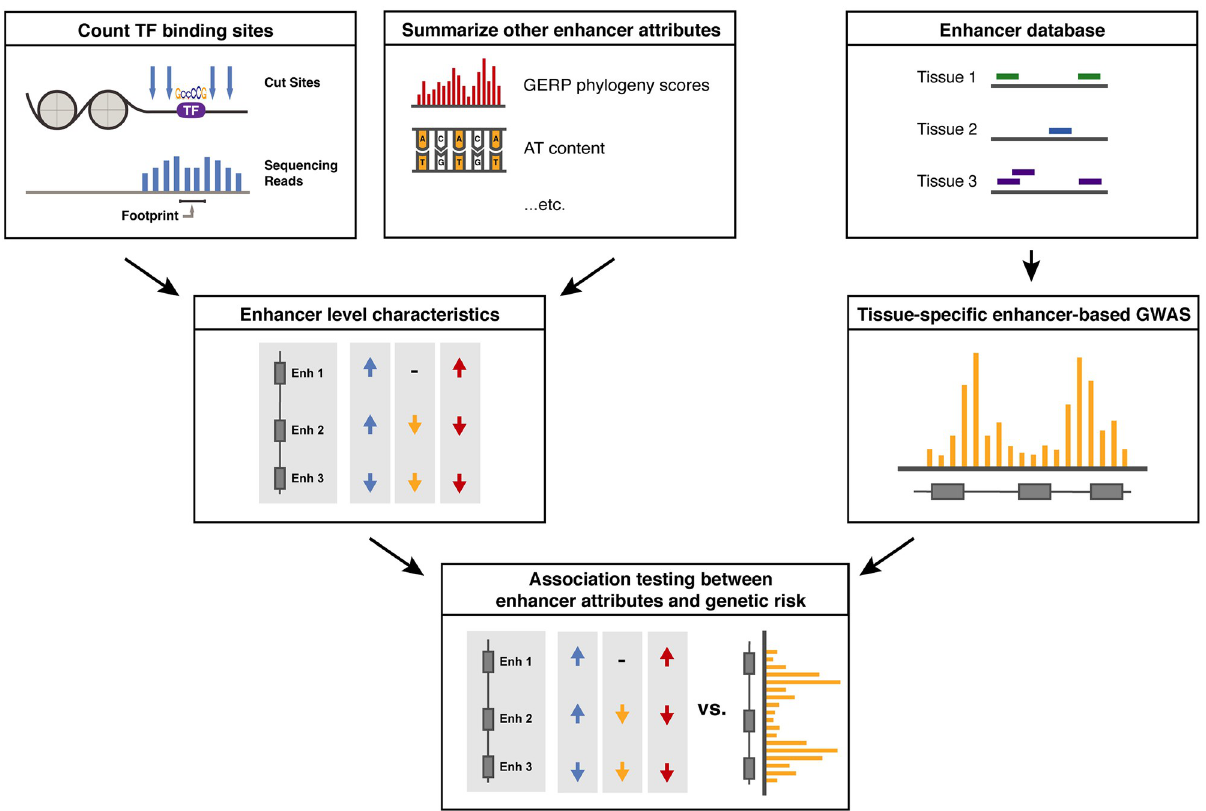
Fig 1. RWAS workflow overview. In brief, the RWAS workflow involves annotating SNPs to enhancers and other regulatory regions (rather than genes). Enhancer-level summary statistics are computed for input into association testing. Then, we use the MAGMA linear modeling framework to compute genetic associations between supplied enhancer-level covariates and these enhancer-based GWAS summary statistics. This approach relies on high-quality enhancer annotations for the tissue of interest that capture genetic risk for the disorder. To ensure these conditions were met, we first thoroughly characterized a set of brain-specific enhancers and demonstrated that these enhancers capture genetic risk for